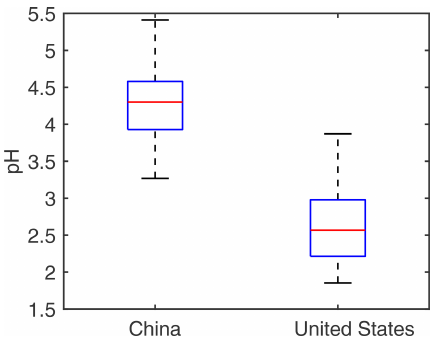
Figure 1. Annual average aerosol pH at each monitoring site in China and the United States based on observational data. The arithmetic mean (midline), the interquartile range (box), and the minimum–maximum range (whiskers) are shown in the box